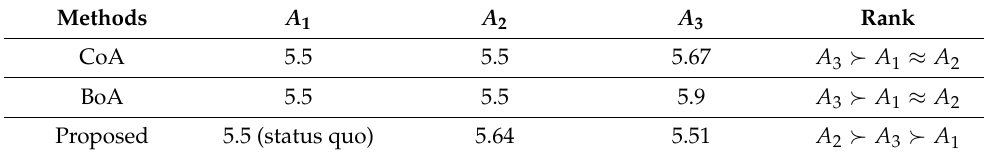
Table 5. The comparison of defuzzifying approaches in Example